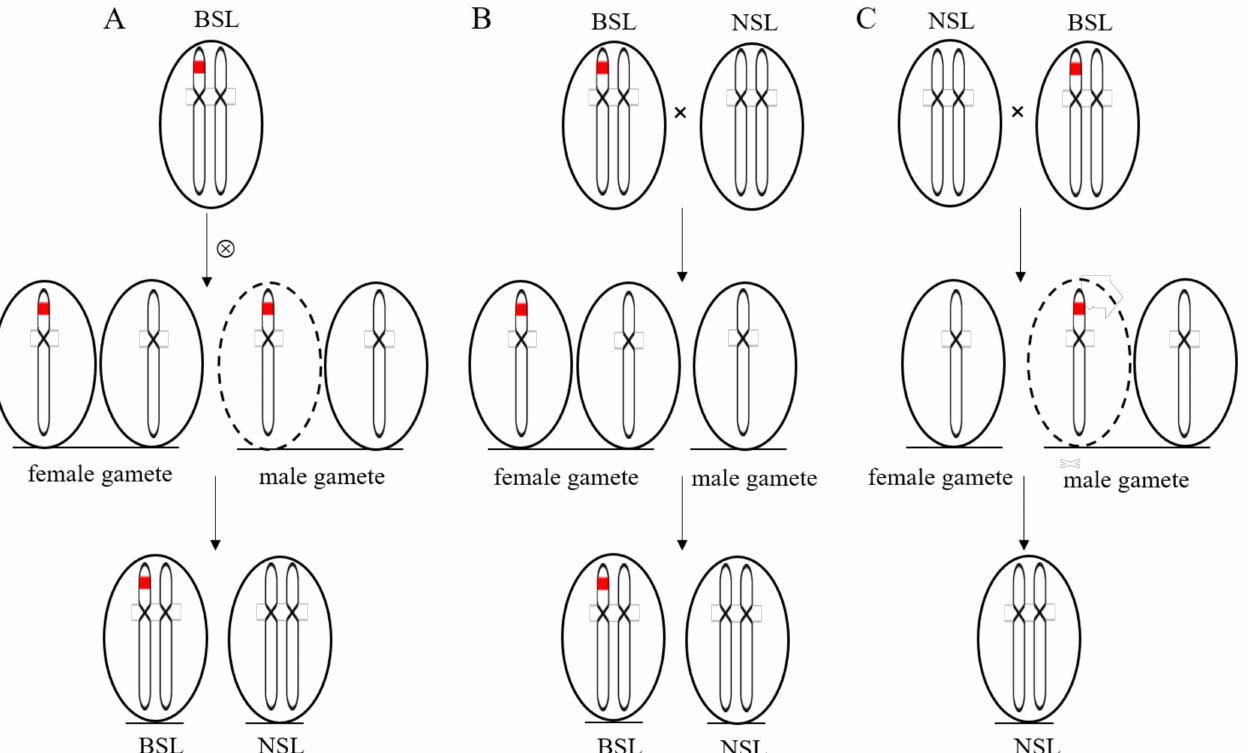
Figure 3. The genetic model of putative heterozygosity at the causal locus for the BSL trait. ( A ) The female gametes develop normally and the male gametes carrying the mutated gene for the branched spikelets aborted, resulting in a 1:1 segregating ratio of the BSL plants and the NSL plants in the offspring of selfed BSL plants. ( B ) The F 1 progenies with the branched and the normal spike segregated by a 1:1 ratio when the BSL plants served as a maternal parent, and ( C ), all the offspring showed normal spike trait when the BSL plant served as paternal parent. The red bar represents the gene for the branched spikelets. The dotted ellipse represents aborted male gamete for the BSL